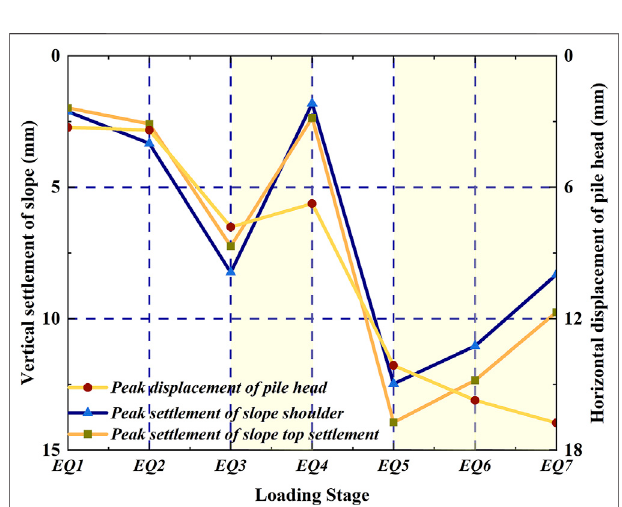
FIGURE 3 | Model displacement and settlement